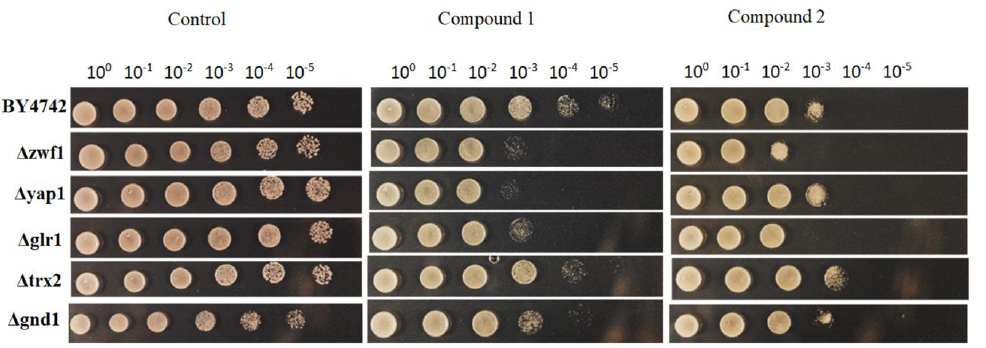
Figure 4. Drop test of Saccharomyces cerevisiae cells on CSM medium containing 5 µ M of test compound. The wt BY4742 was compared with the mutants. Drops (10 µ L) of serial dilutions up to 10 − 5 were plated out. In the control, both wt and mutant cells behaved similarly and grew down to the 10 − 5 dilution. In the drop test, 10 µ L of 10 − 5 fold serial dilutions were spotted onto medium containing 5 µ M of the test compound. The control plate comprised of medium only. The ability of wildtype (wt) BY4742 cells to grow in the presence of selenocyanates was compared with that of ∆ yap1 , ∆ glr1 . ∆ gnd1 , ∆ trx2 and ∆ zwf1 yeast